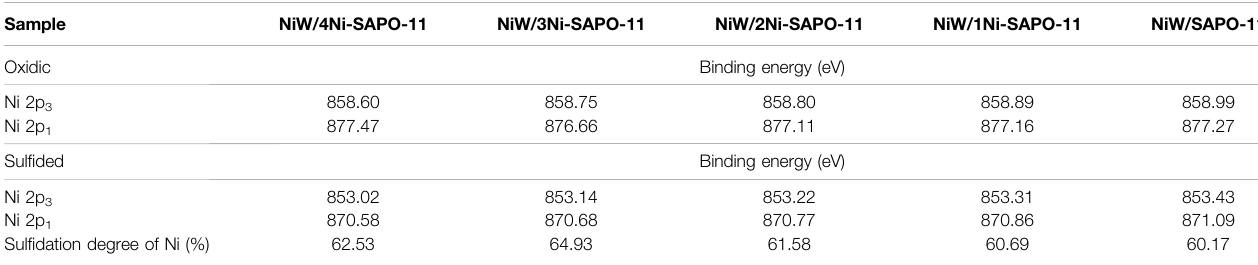
TABLE 6 | Binding energy and sul fi dation degree of Ni on different catalysts.